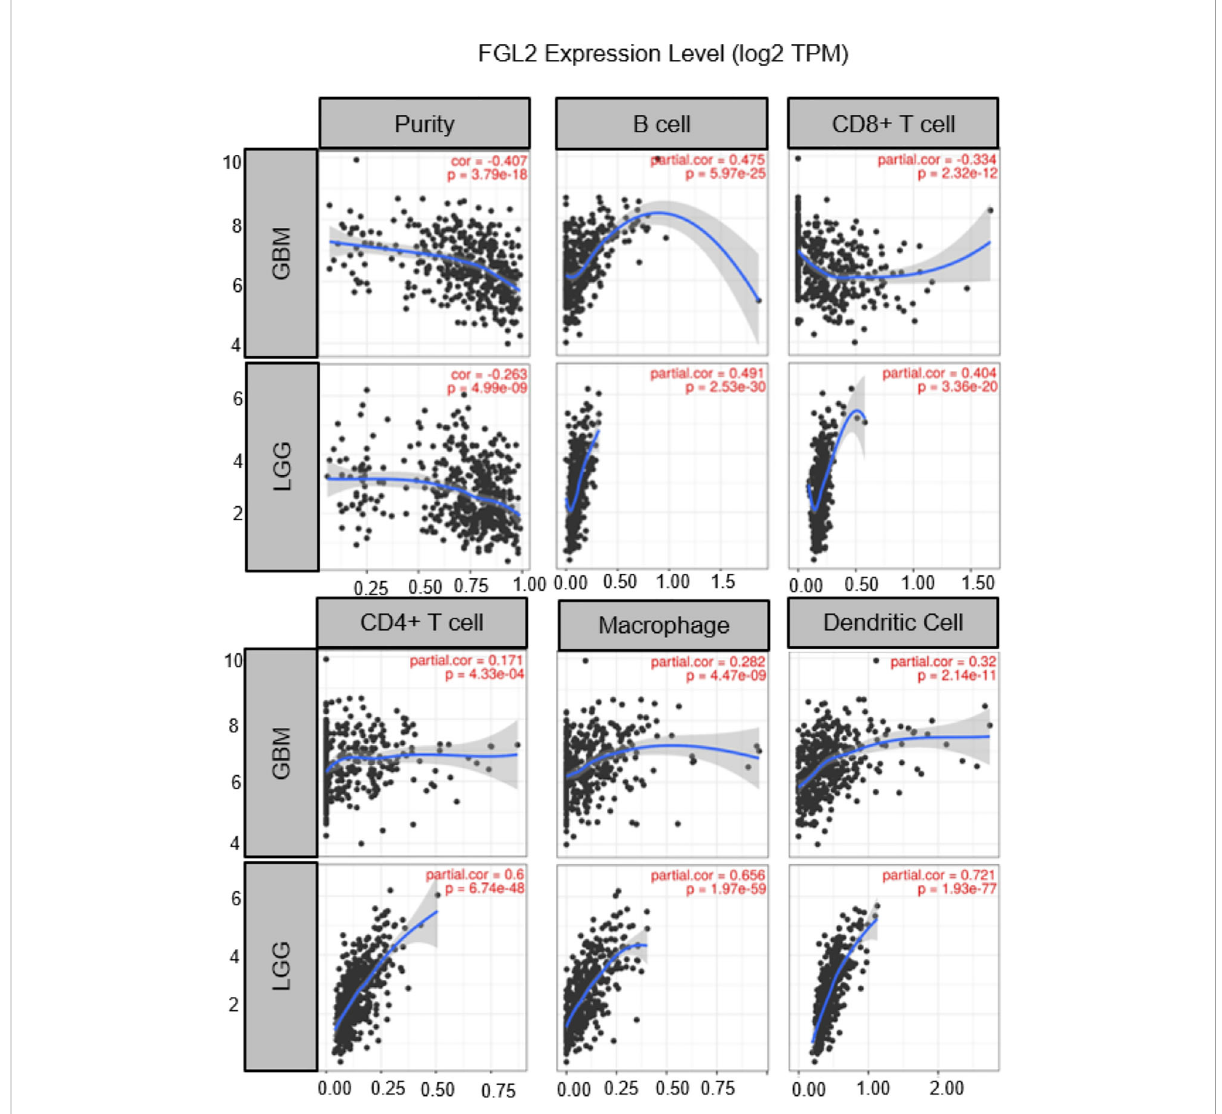
FIGURE 2 Correlation of FGL2 with immune cells. The fi gure was excerpted from TIMER